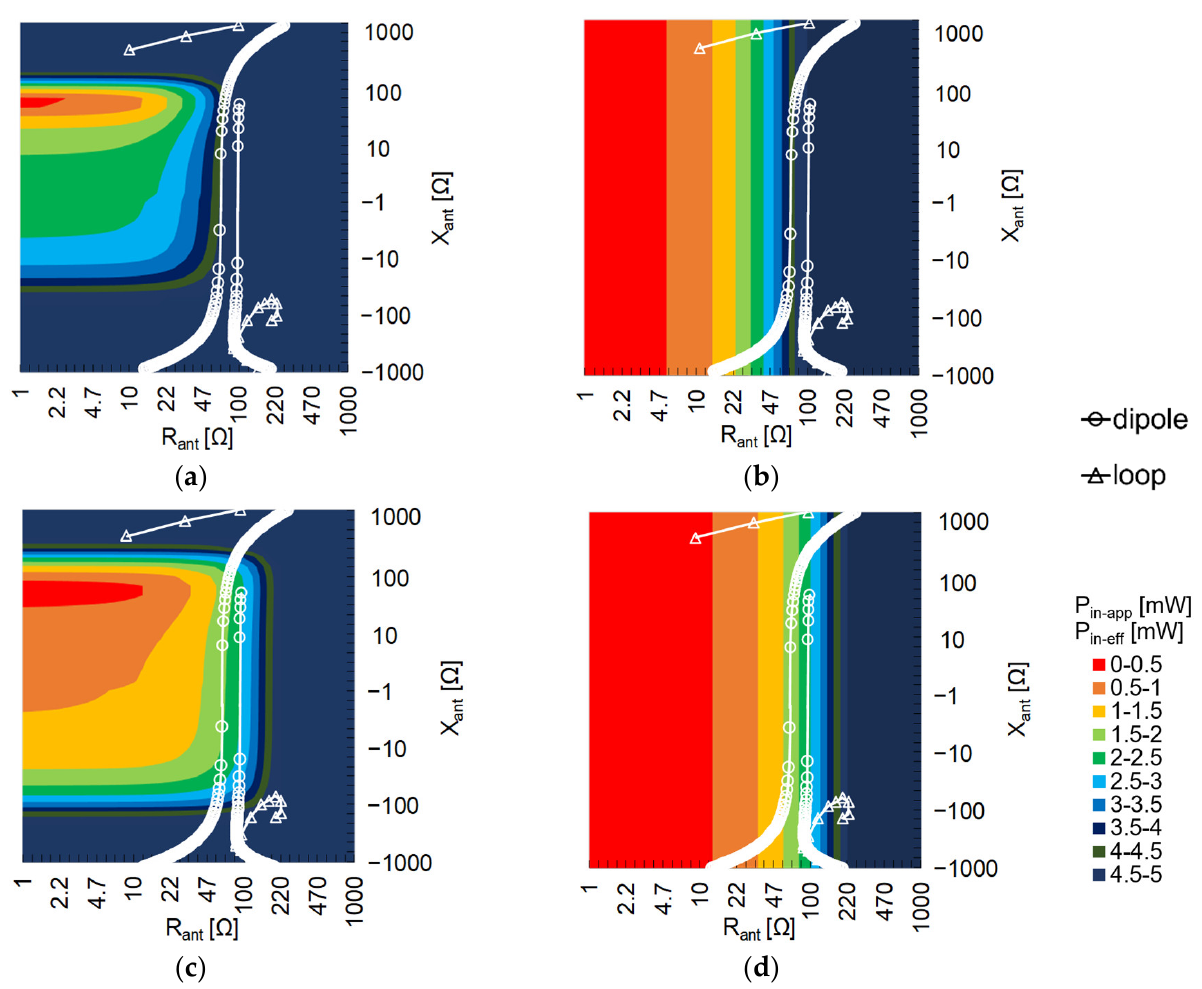
Figure 13. Contour plots of input power with model 1 at P out = 100 µ W: ( a ) P in − app (SD), ( b ) P in − ef f (SD), ( c ) P in − app (VD), ( d ) P in − ef f (VD).